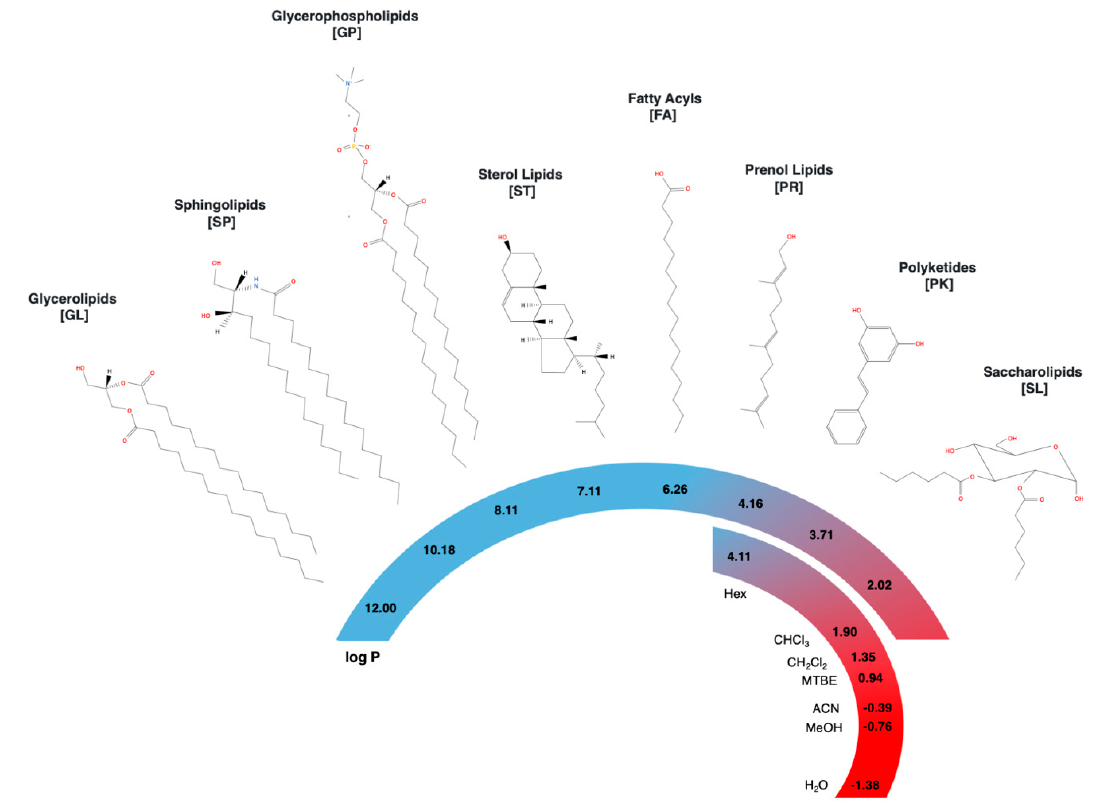
Figure 1. LIPID MAPS categories and representative structures with calculated octanol / water partition coefficient (log P) using ChemAxon. Reported log P of solvents used in lipidomics are indicated below [30]. Color code represents relative polarity, non-polar (blue), and polar (red). Example of classes corresponds to Glycerolipids, DG(16:0/16:0/0:0)—L02010001; Sphingolipids, SP(16:0/16:0)—LMGP01010564; Glicerophospholipids, PC(16:0/16:0)—LMGP01010564; Sterol lipids,